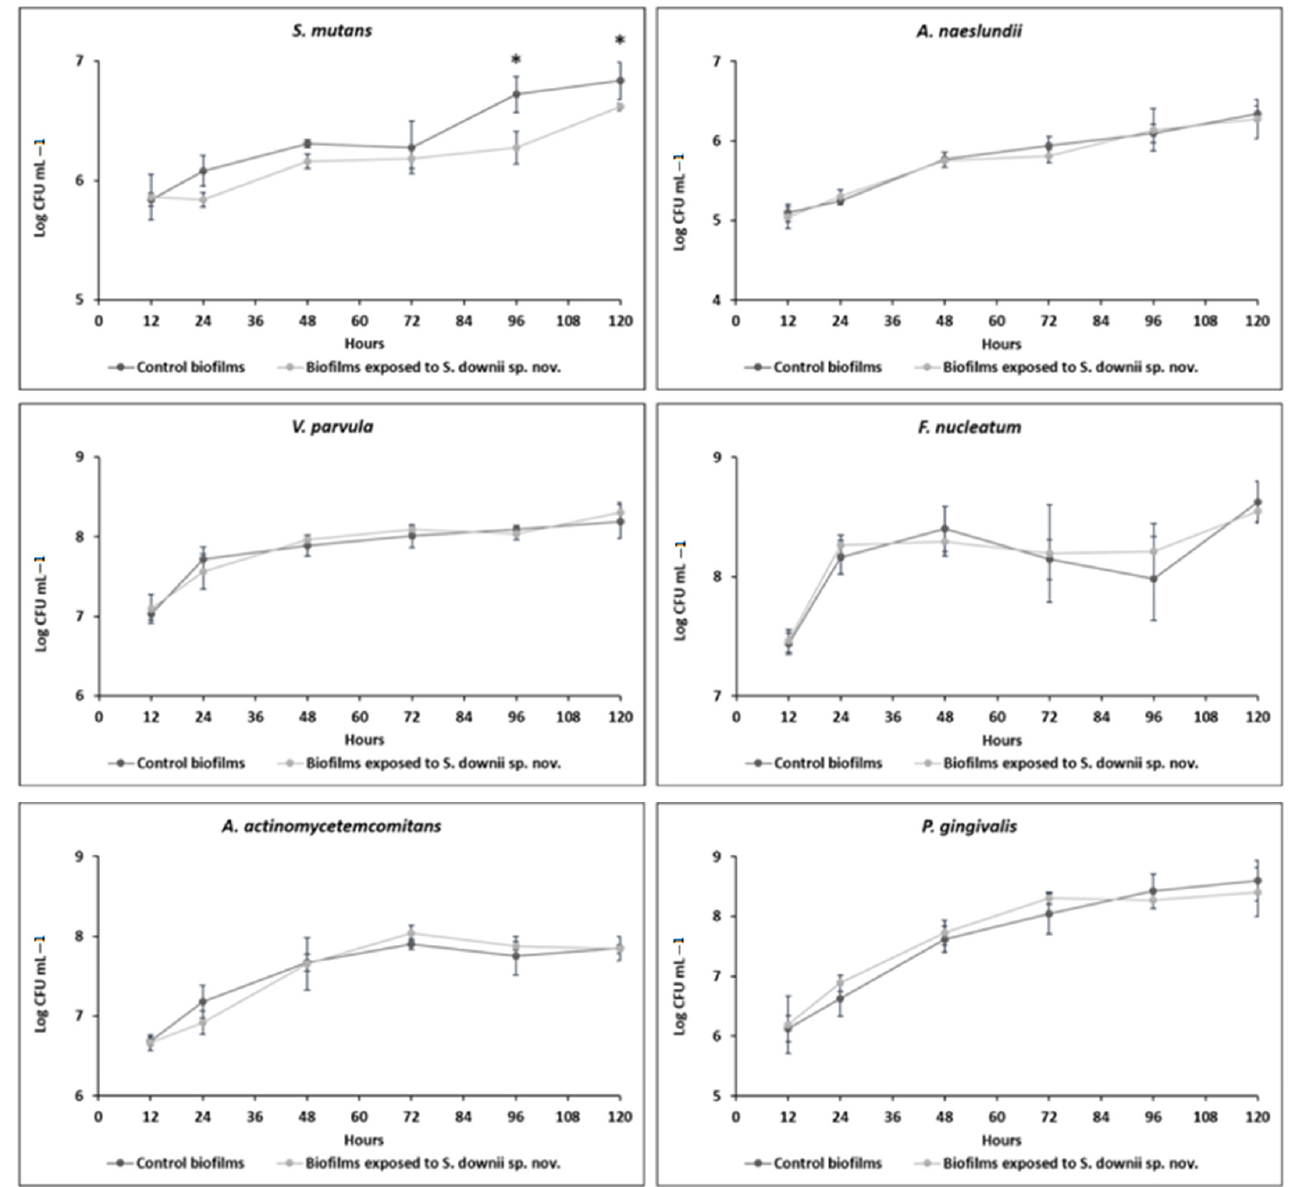
Figure 2. Kinetics of incorporation of the six selected bacterial strains in the biofilm [expressed as logarithm of Colony Forming Units per mL, (log CFU mL − 1 )] on the two biofilm modalities compared in the study: control biofilms (composed of Streptococcus mutans, Veillonella parvula, Actinomyces naeslundii, Fusobacterium nucleatum, Aggregatibacter actinomycetemcomitans, and Porphyromonas gingivalis ) and experimental biofilms, incorporating also Streptococcus downii sp. nov. Analyses have been performed with quantitative polymerase chain reaction, in biofilms from 12 h to 120 h of incubation, using specific primers and probes directed to the 16S rRNA gene. * p <